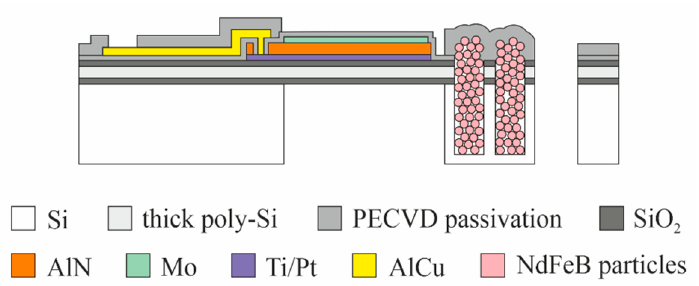
Figure 5. Schematic cross-section of the MEMS piezoelectric energy harvester with integrated NdFeB-based micromagnets.